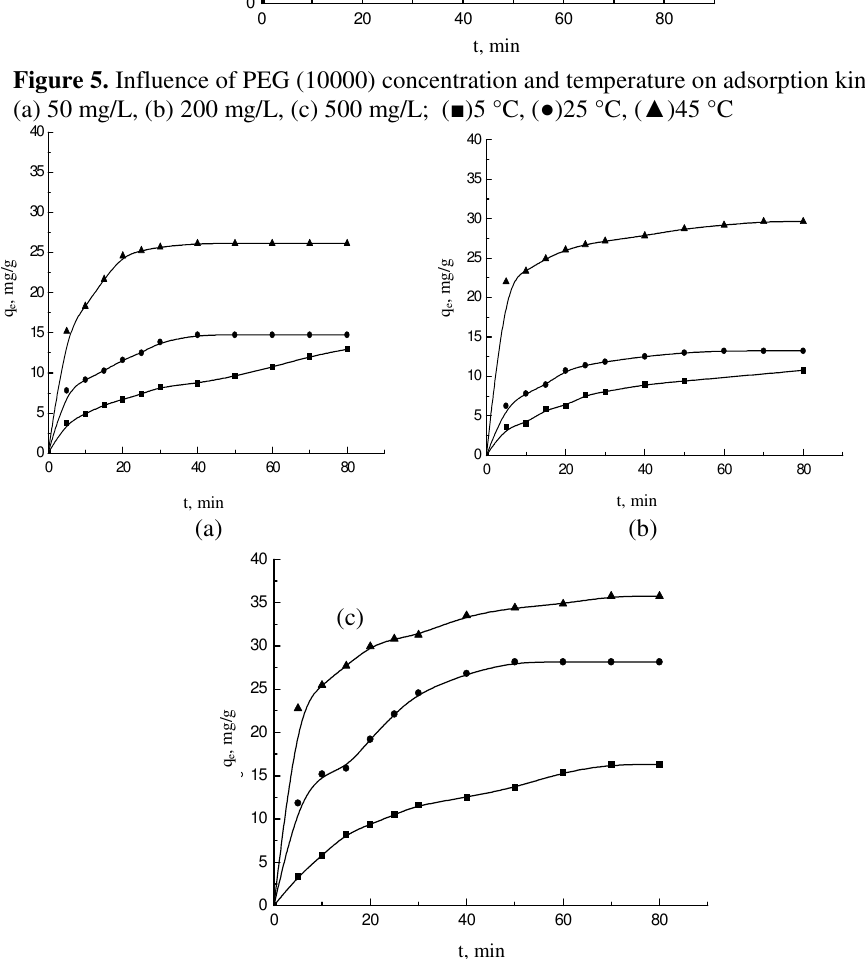
Figure 6. Influence of PEG (20000) concentration and temperature on adsorption kinetics. (a) 300 mg/L, (b) 500 mg/L, (c) 700 mg/L; ( ■ )5 °C, ( ● )25 °C, ( ▲ )45